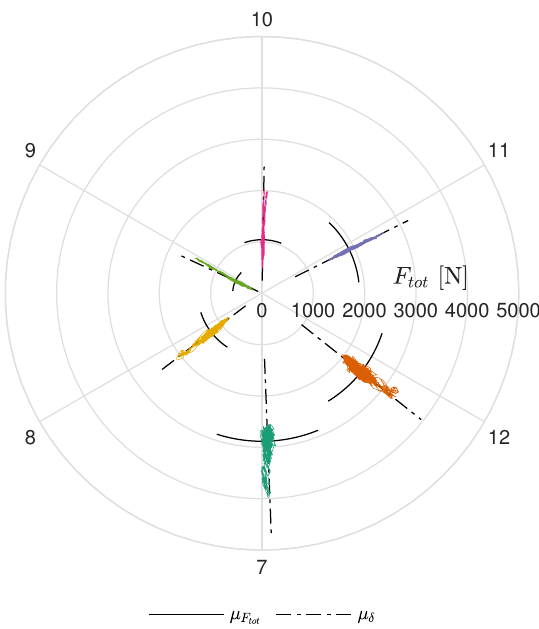
Figure 15: Plot showing forces F tot on panel 711 return strain rollers, together with the mean force µ F and mean angle µ δ are shown. tot